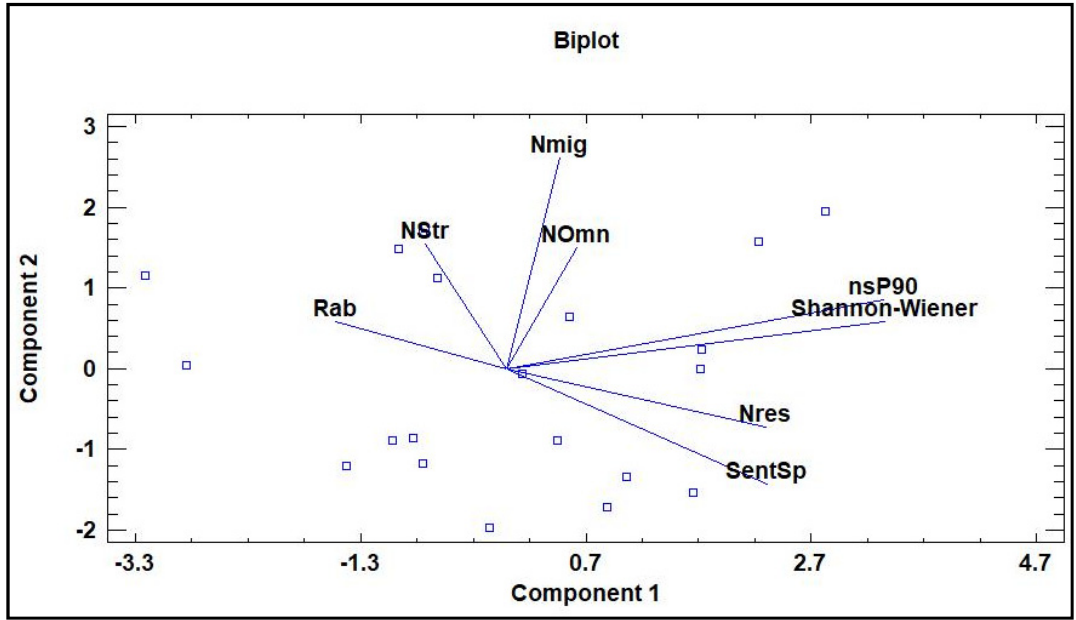
Figure 2. PCA analysis of the eight metrics that were included in the LFI. The first four axes explained the variation among those metrics at 85.09% with an eigenvalue of 1.09. The analysis indicates that the eight parameters are important in explaining the differences between the sampling stations.